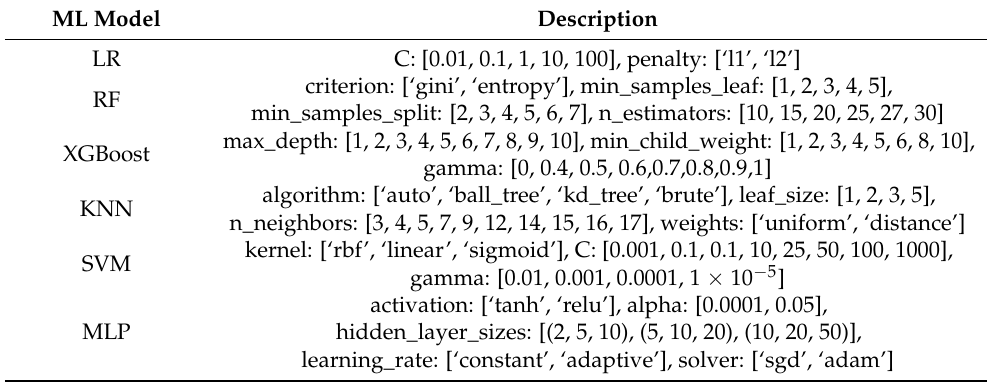
Table 2. ML hyperparameters tested in our